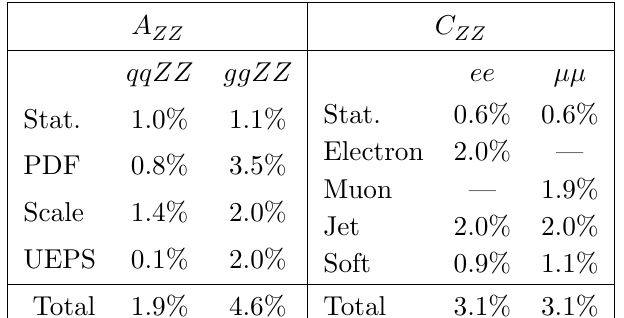
Table 5 . Fractional uncertainties for A and C , with the contributions from the various sources, ZZ ZZ theoretical only for A and experimental only for C . The uncertainties in A ZZ ZZ and ggZZ sub-processes are given in di(cid:11)erent columns. The uncertainties in C (cid:22)(cid:22) channels of the inclusive ZZ process are given in separate columns. The total uncertainties in A and C are given in the last rows, respectively. The \Soft" term includes the E miss ZZ ZZ and the pile-up uncertainties.